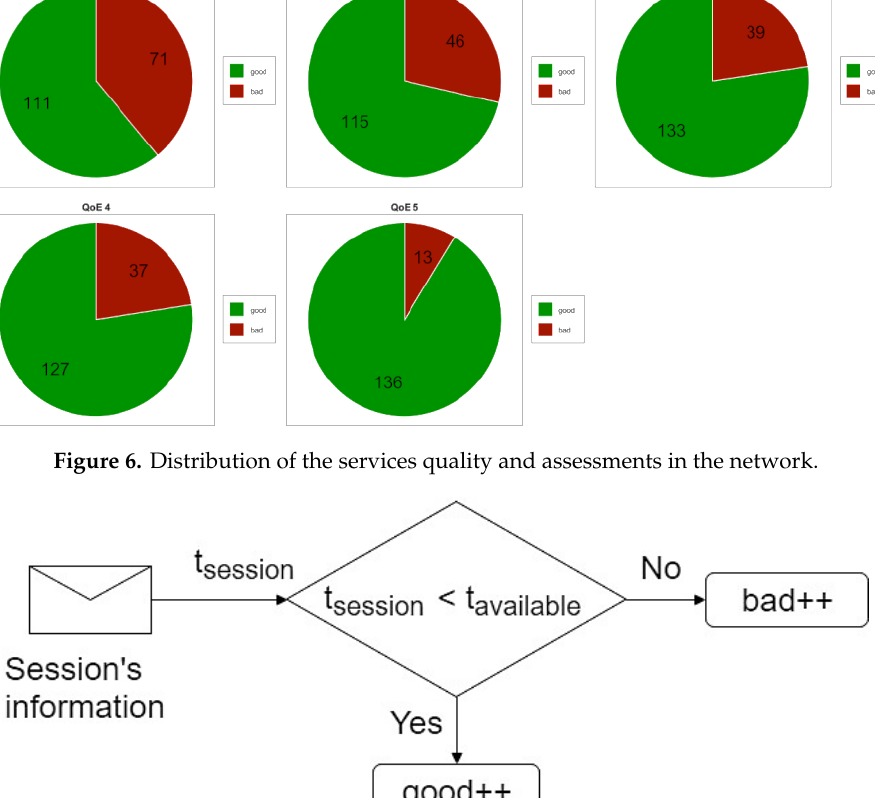
Figure 7. The scheme of decision making for the construction of diagrams.